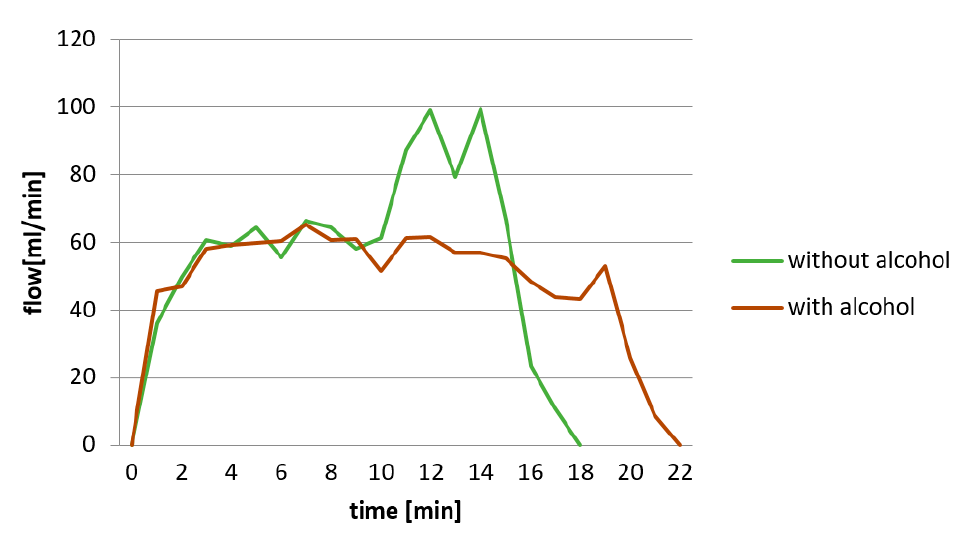
Figure 7. Comparison of the hydrogen flow rate generated from an aluminum A1 sheet of 20 × 30 × 0.5 mm 3 in a 7.5 M NaOH solution, with and without isopropyl alcohol in a water bath at 60 °C.